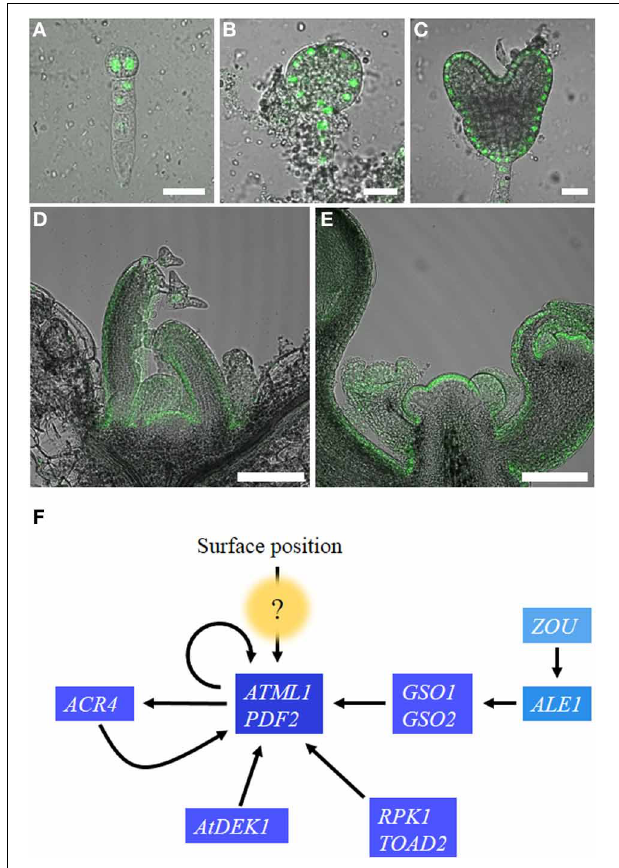
FIGURE 1 | Regulation of ATML1 expression in the embryos and shoot apices. ATML1 promoter activity visualized using a nuclear-localized GFP reporter in the developing embryos (A–C) and the shoot apices (D,E) . Two-cell stage (A) , early globular stage (B) , and heart stage (C) embryos are shown. GFP expression is restricted to the outermost cell layer after the 16-cell stage. Epidermis-specific expression is observed in vegetative (D) and inflorescence (E) shoot apices. (F) Genetic interactions among genes involved in epidermal cell fate specification during Arabidopsis thaliana embryogenesis. Arrows indicate positive interactions. The question mark indicates currently unknown components. For details, please see the main text. Scale bars, 20 µ m in (A–C) ; 100 µ m in (D,E)